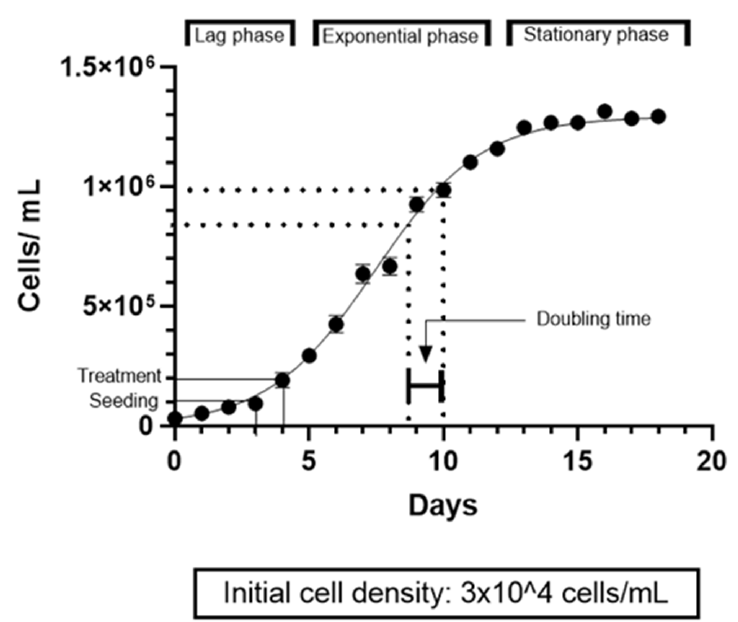
Figure 1. Growth curve of MCF-7 cells grown in culture. Initial cell density is 3 × 10 4 cells/mL. Results are expressed as mean ± standard error of the mean (SEM) of three independent experiments ( n = 3). The doubling time of MCF-7 cells is 30 to 40 h, and we obtained doubling times of 37 h, 33 h and 30 h for 1 × 10 4 cells/mL, 3 × 10 4 cells/mL and 1 × 10 5 cells/mL, respectively. Therefore, the MCF-7 cells used in our study were within the typical doubling time values, according to ATCC